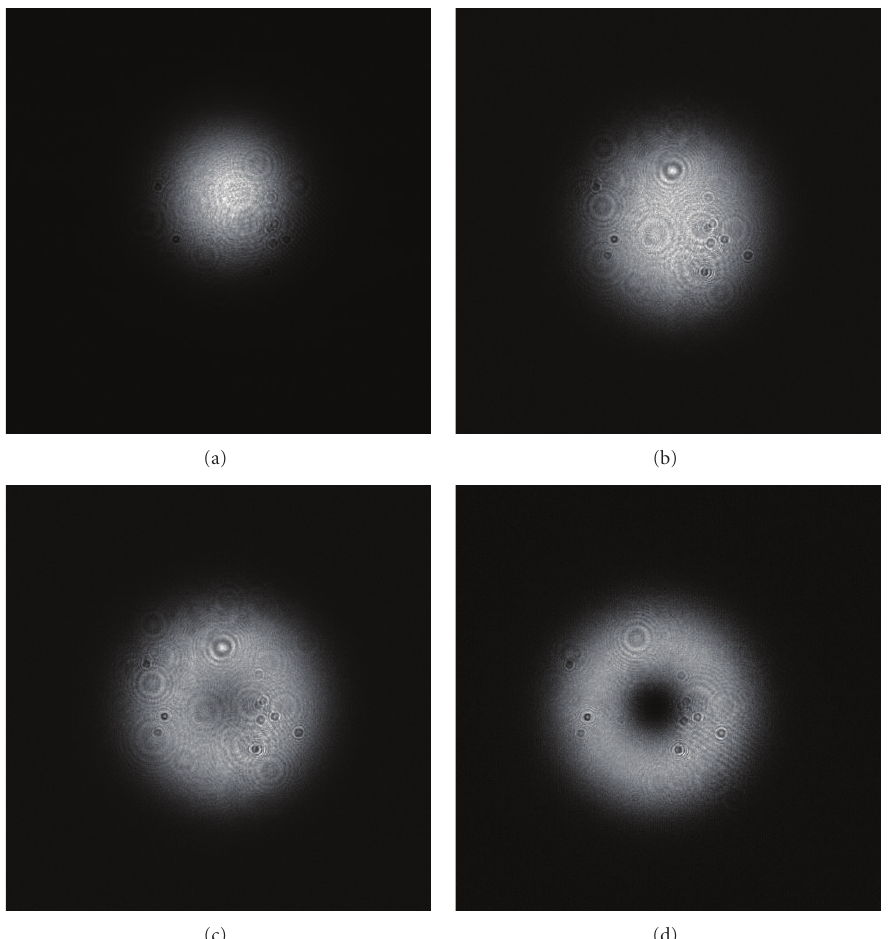
Figure 2: Intensity distributions of the generated beams for di ff erent spot defect diameters d of (a) 0 μ m, (b) 13 μ m, (c) 20 μ m, and (d) 50 μ